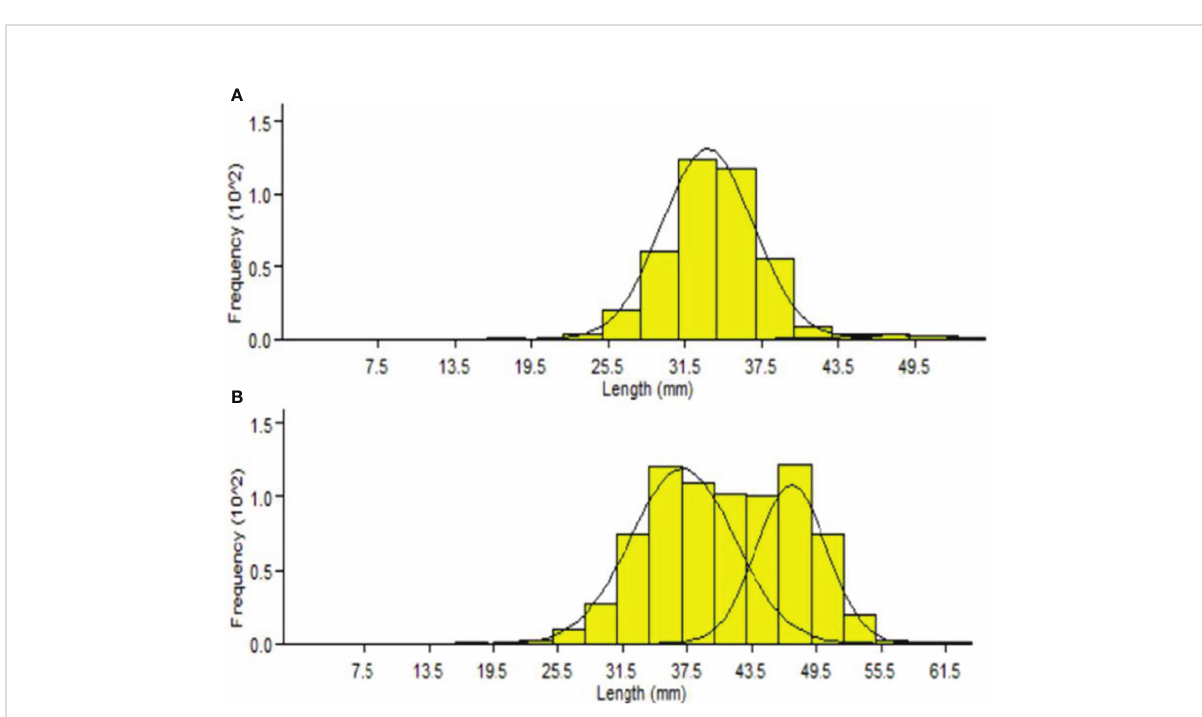
FIGURE 11 Cohort analysis output from FiSAT II for (A) male and (B) female P. elegans from the southeast Caspian Sea (2019 –